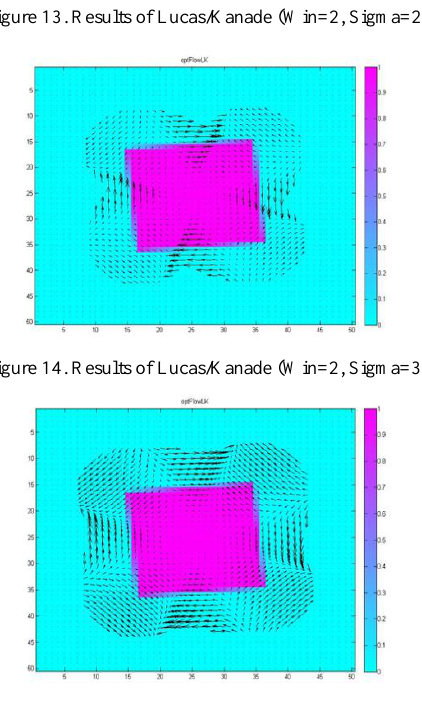
Figure 15. Results of Lucas/Kanade (Win=2, Sigma=5)